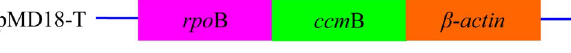
Figure 1. The control pMD18-T-VCQA vector.